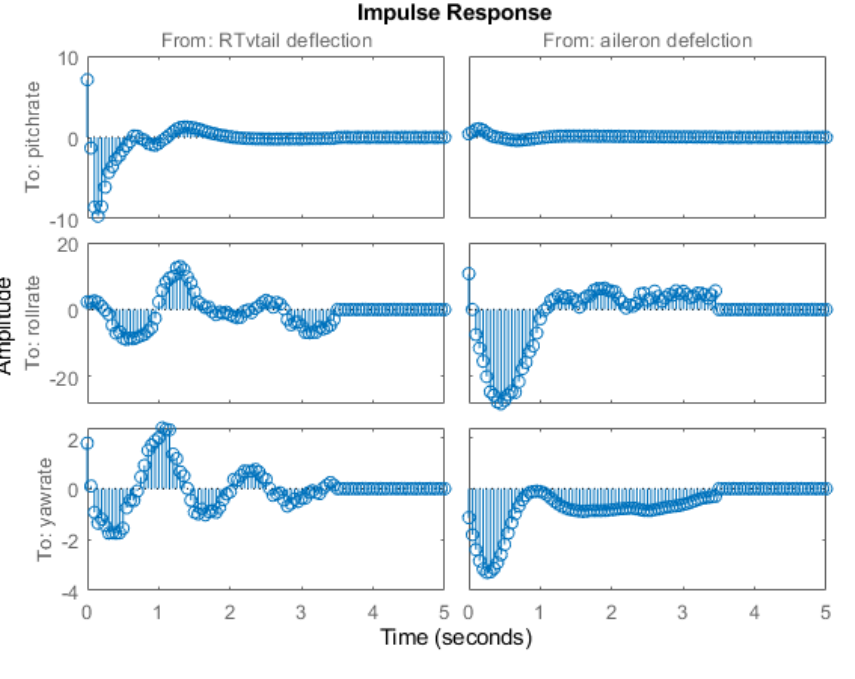
Figure 9. Finite Impulse Response.